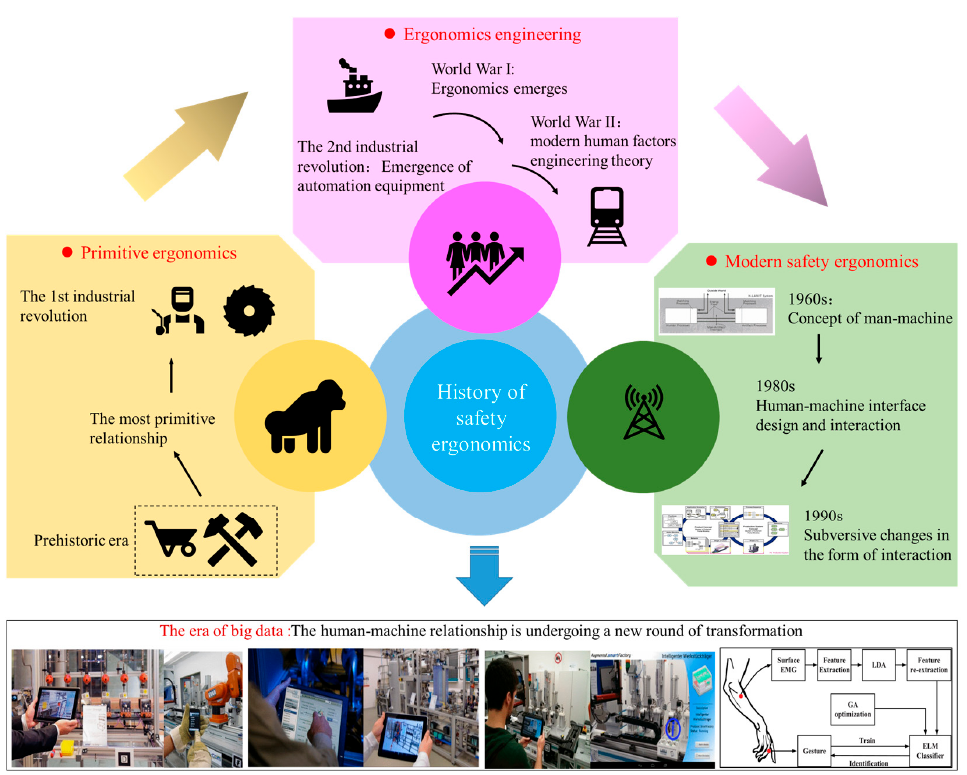
Figure 1. The developmental history of ergonomics. The development of safety ergonomics can be summarized into three development stages: primitive ergonomics, ergonomics engineering, and modern safety ergonomics.